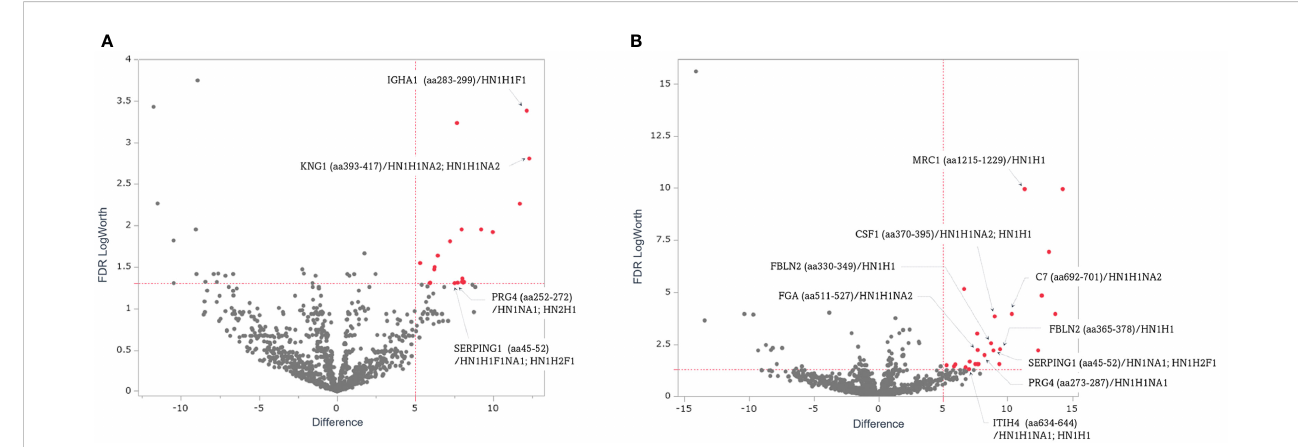
FIGURE 4 Quantitative comparison of the O-glycoforms of advanced CRC and healthy control serum samples. Volcano plots of O-glycoforms of patients with advanced CRC compared with those of the healthy controls. (A) NCE27, (B) NCE35. Red dots: difference ≥ 5.00; FDR LogWorth ≥ 1.3.